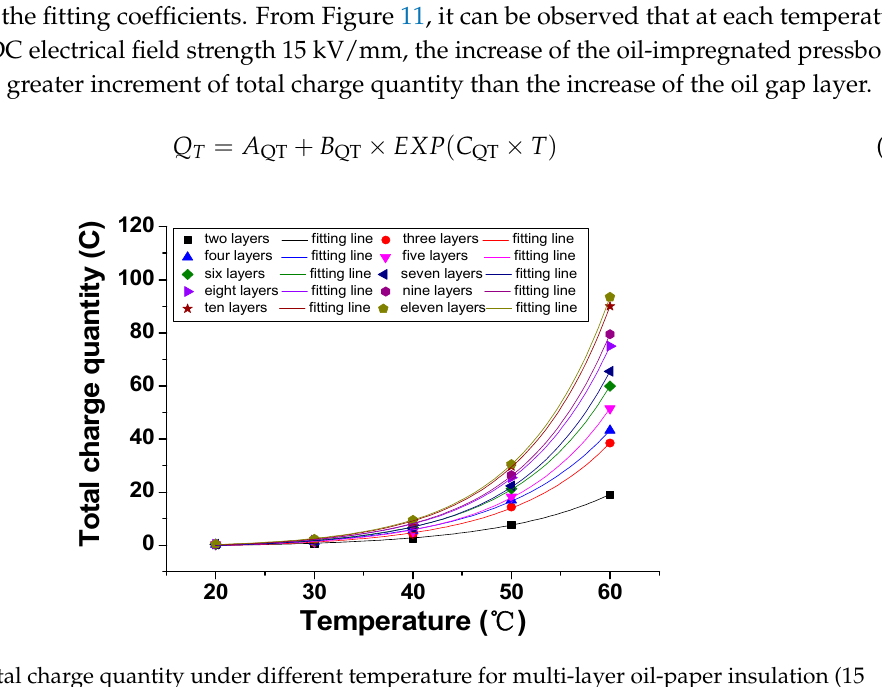
Figure 11. Total charge quantity under different temperature for multi-layer oil-paper insulation (15 kV/mm). Table 5. Fitting parameters for the total charge quantity at steady state (1800 s) under different temperatures for multi-layer oil-paper